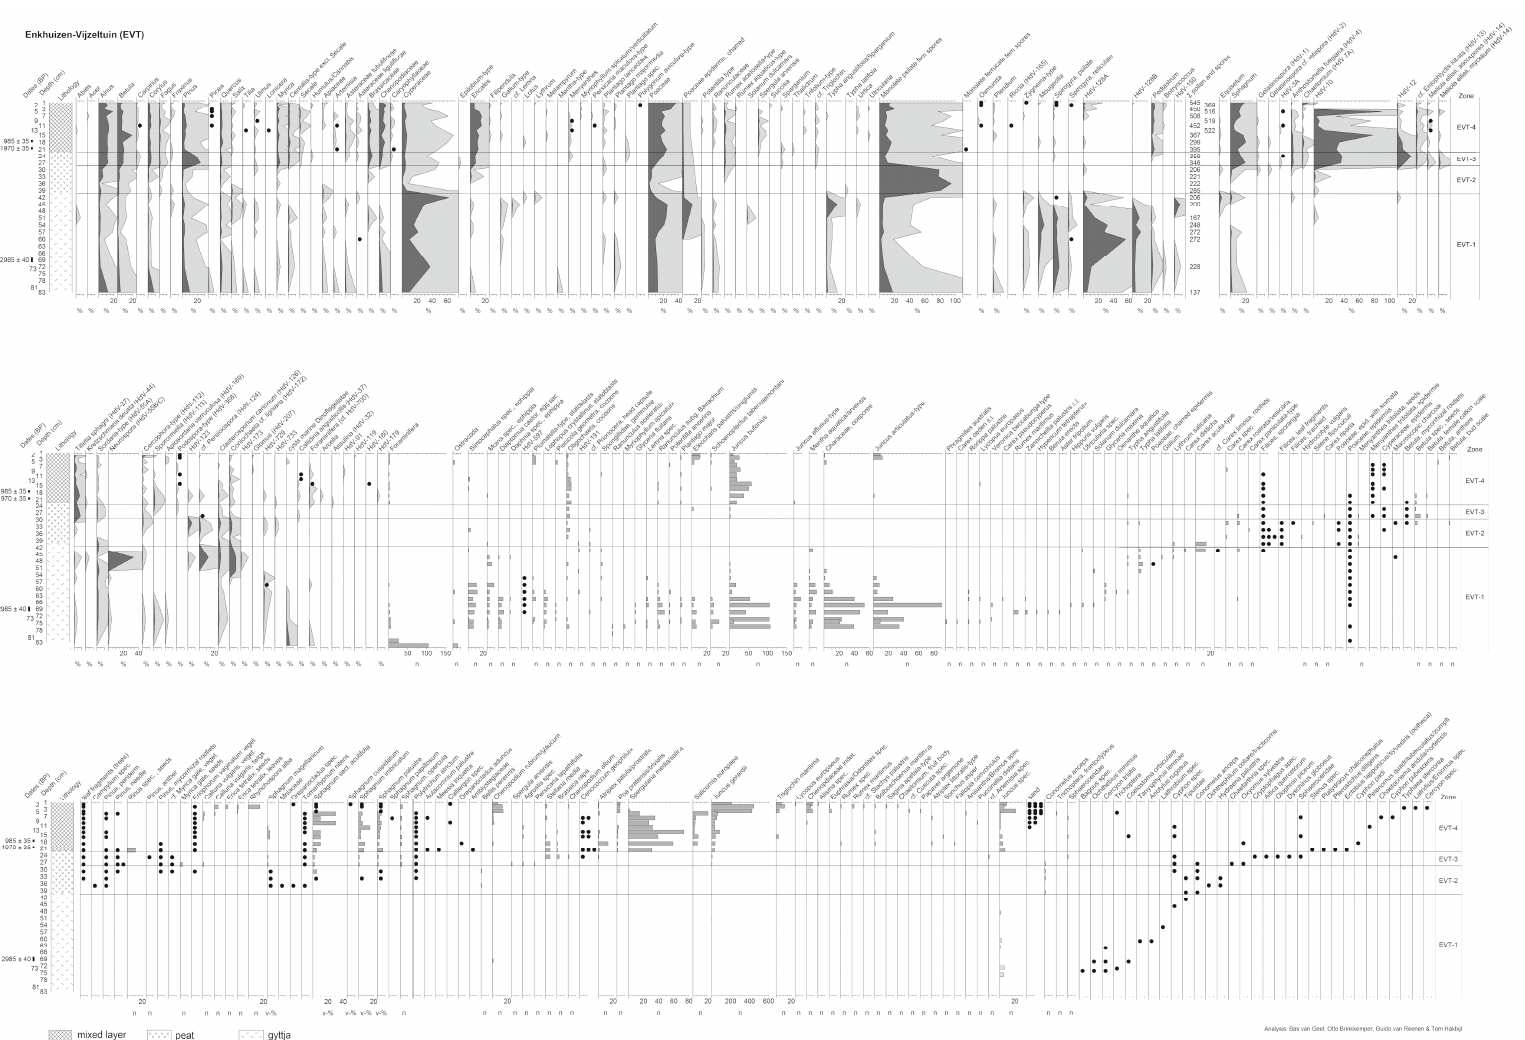
Figure 5. Diagram of Enkhuizen-Vijzeltuin.